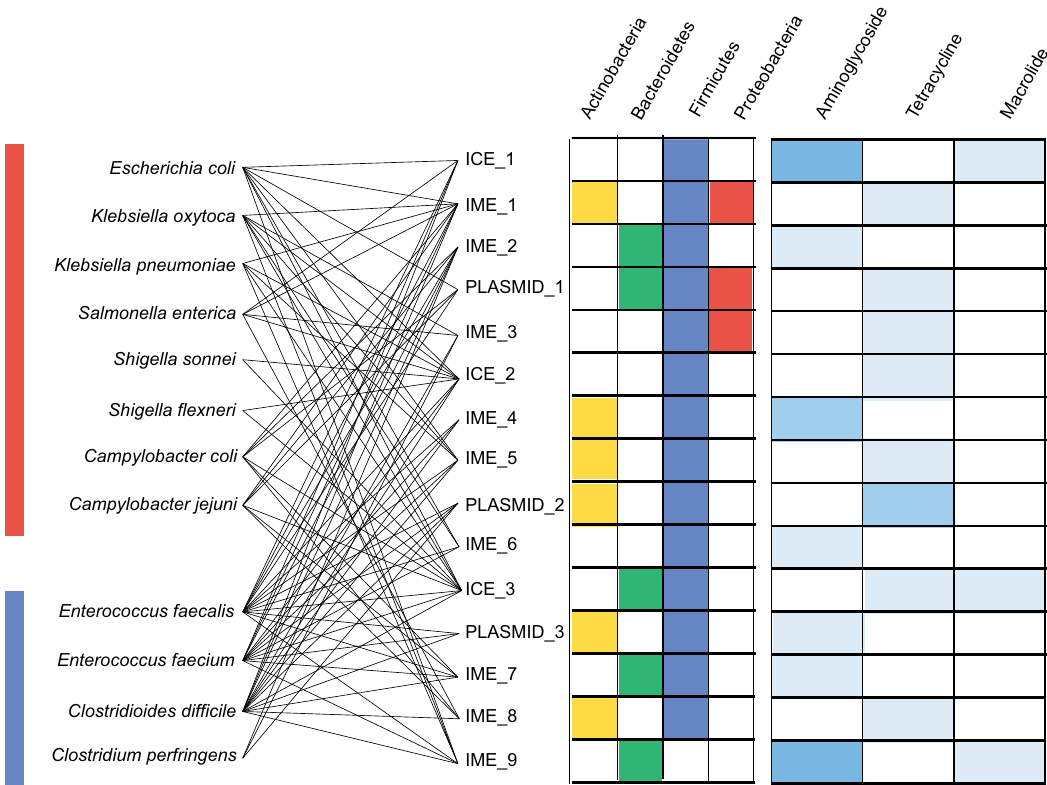
Fig. 2 Taxonomic distribution and functional composition of 15 broad host range mobile genetic elements. Occurrence of 15 promiscuous elements shared between pathogenic bacteria and commensal Actinobacteria (yellow), Bacteroidetes (green), Firmicutes (blue), and Proteobacteria (red). The presence of 1 (light blue), 2 (moderate blue) or 3 (dark blue) ARGs (Aminoglycoside, Tetracycline, Macrolide). Connecting lines show the presence of promiscuous elements in respective pathogenic